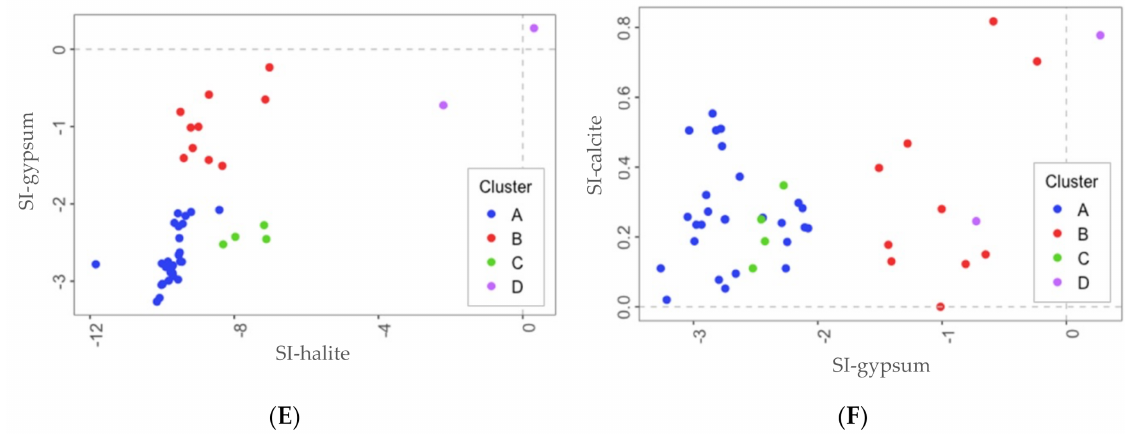
Figure A2. Bivariate relationship graphs. ( A ) SI calcite vs. TDS (mg/L); ( B ) SI dolomite vs. TDS (mg/L); ( C ) SI gypsum vs.